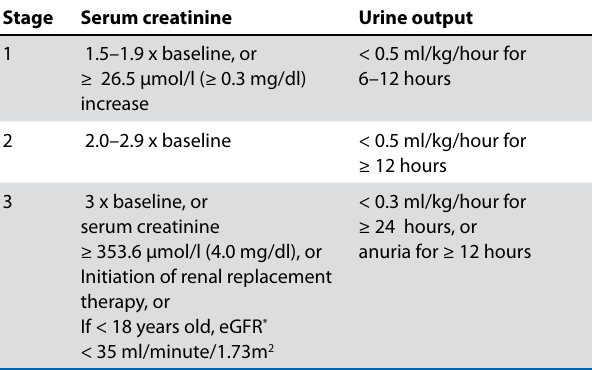
Table 1: Staging of acute kidney injury 2 Stage